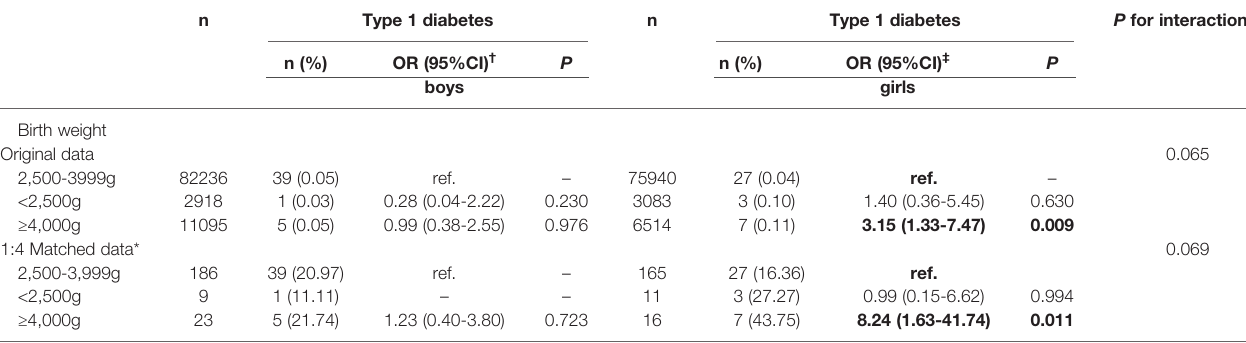
*Caseswereselectedaccordingtoquestionnaire,controlswerematchedbyPropensityScoreMatchingandthematchingvariablesincludedmaternalageatdelivery,maternaleducation, annual family income, diabetes of mother, father and siblings, maternal gestational diabetes, children ’ s characteristics including age, gender and breast feeding. † Adjustment for variables the same as matching variables above and preterm birth or not; ‡ Adjustment for preterm birth or not. **P value of the interaction between birth weight and gender. Bold values means statistically signi fi